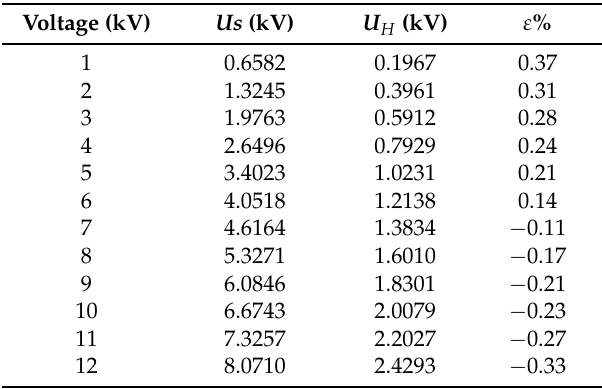
Table 6. Results of Phase